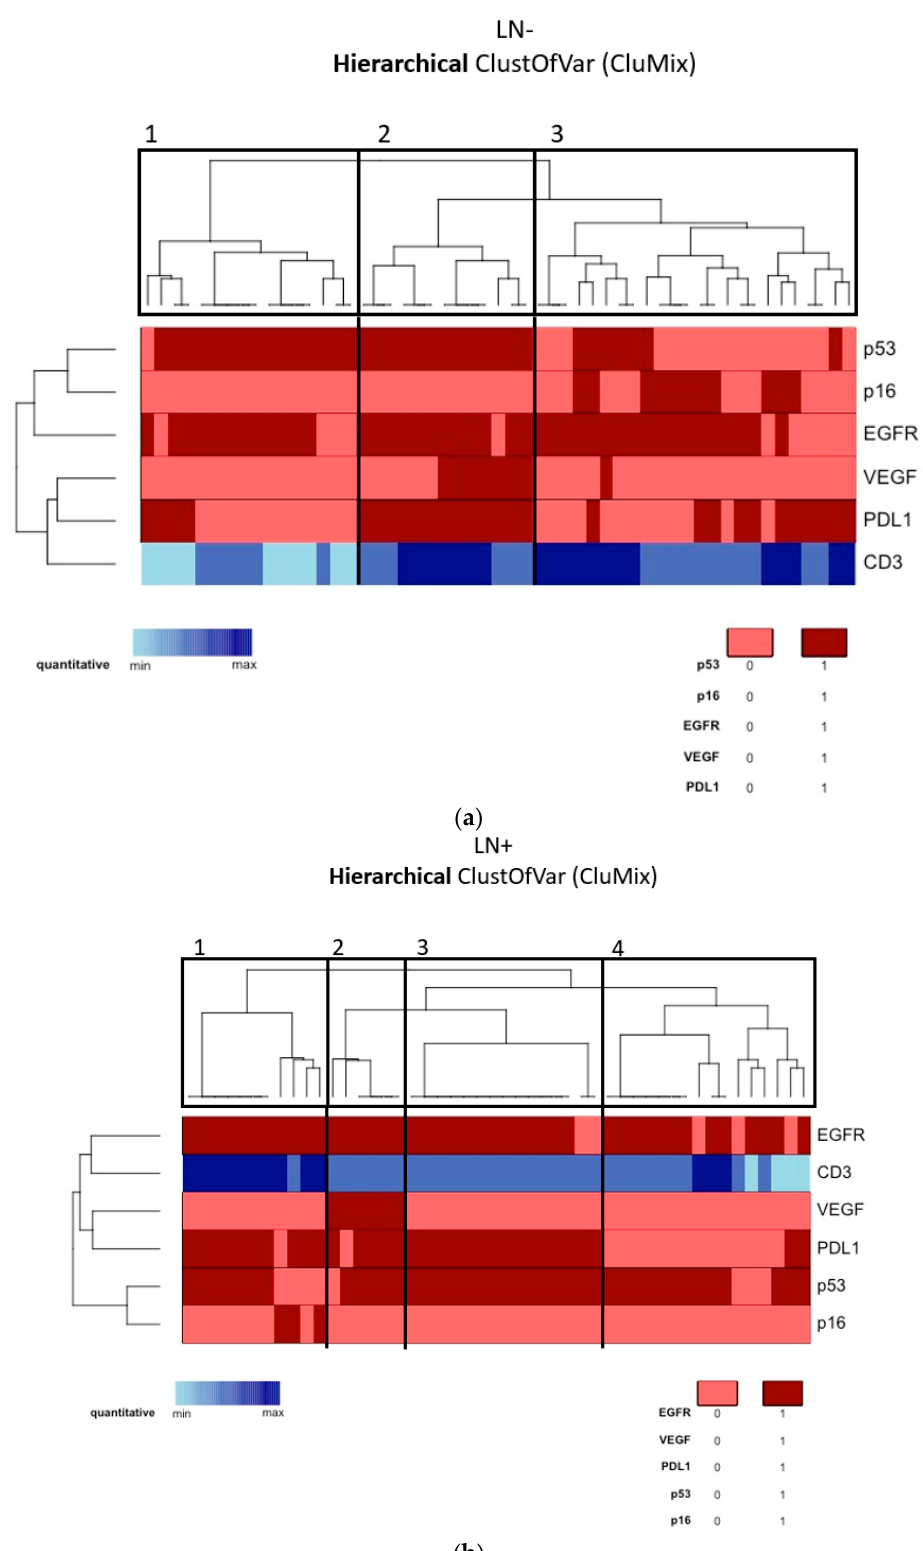
(43.9%) metastatic lymph nodes compared to the primitive vulvar tumor (Figure 3). Num ‐ bers on the diagonal are a measure of the similarity between statistical units (molecular “fingerprint” of the samples), which we have considered relevant if >0.7.